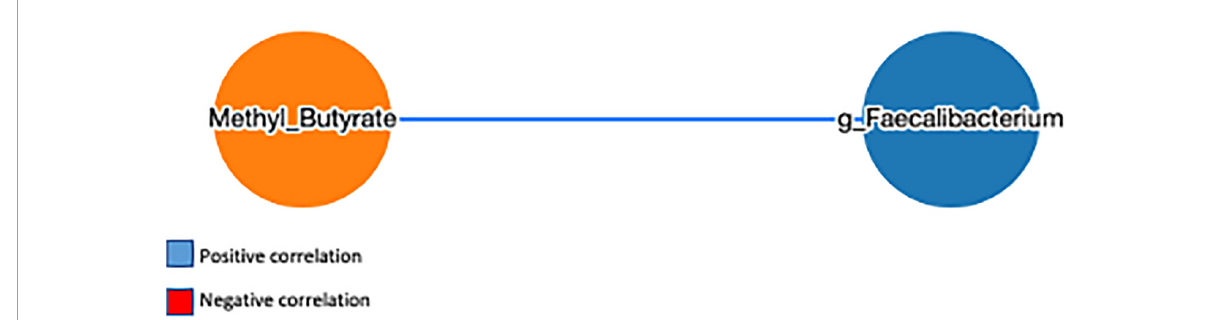
FIGURE8 Network analysis performed using a MetagenoNets webtool. Analysis revealed that only 2-methyl butyrate positively correlated with the genus Faecalibacterium among all significant bacteria, diet, and SCFA. Blue color indicates a positive correlation, whereas red color indicates a negative correlation.